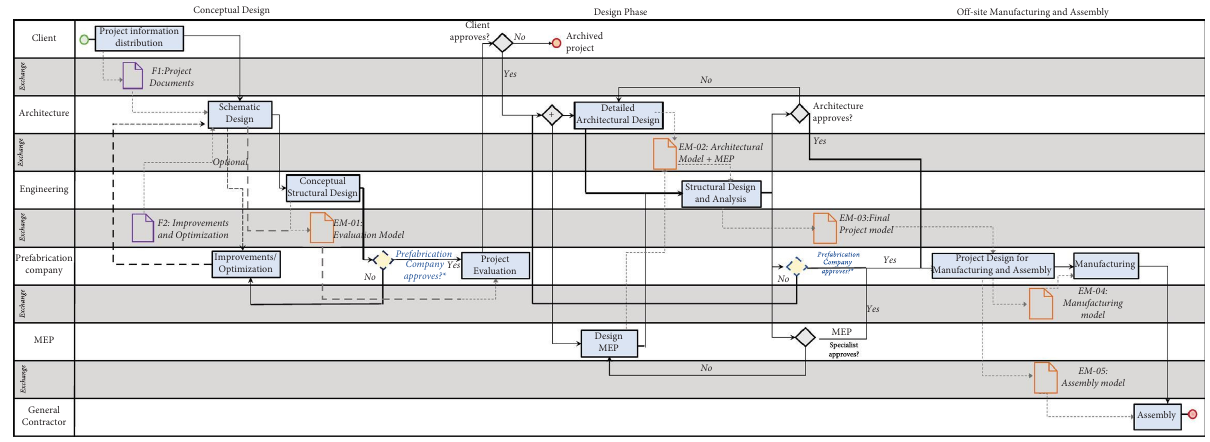
Figure 2: Process map associated with the development of prefabricated timber